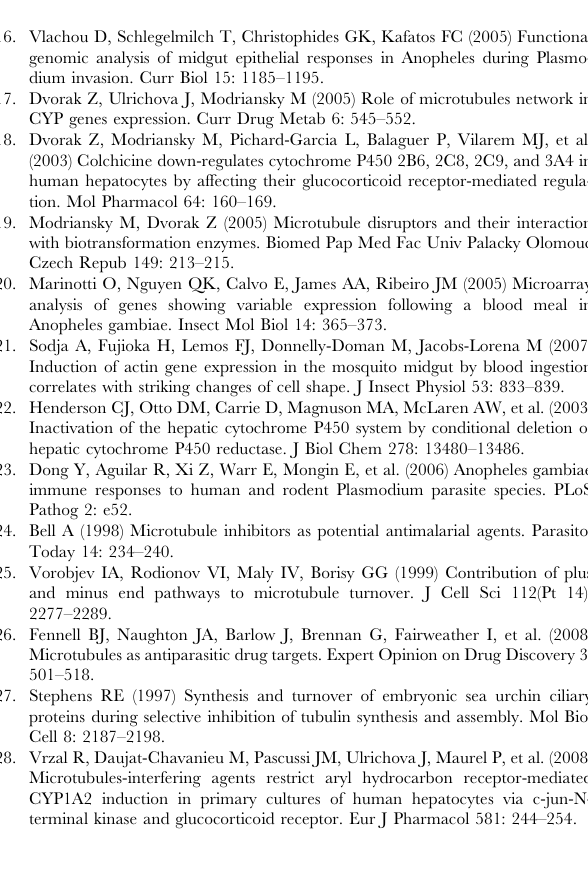
Table S1 Primers used for dsRNA synthesis and